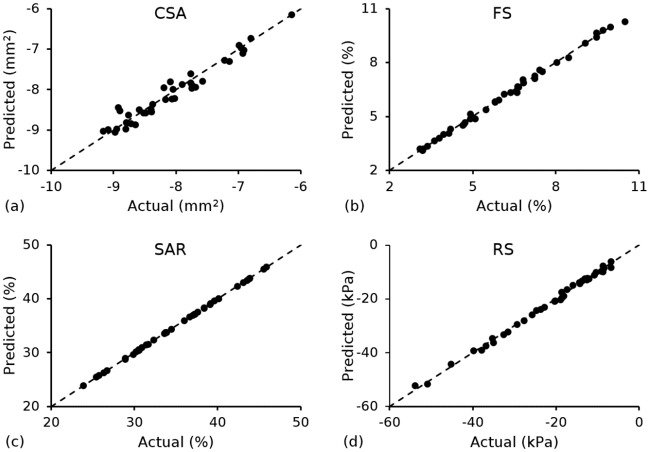
Predicted response using the statistical model in Eq 16 vs. actual (measured) response from finite element simulations for (a) CSA; (b) FS; (c) SAR and (d) RCP.